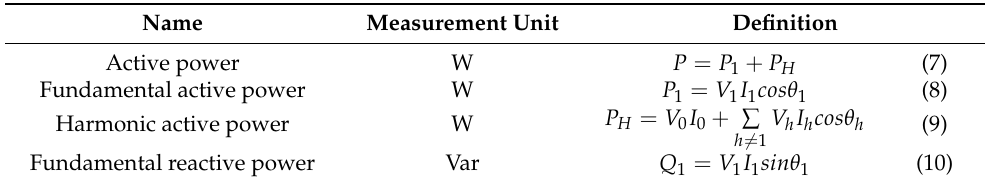
Table 1. Definitions of the considered power quantities under non-sinusoidal conditions, according to